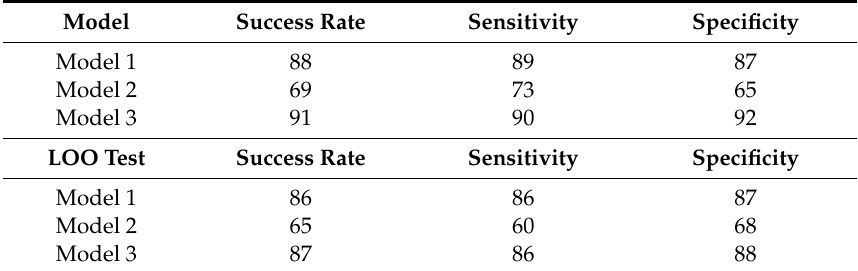
Table 5. Model comparison based on the ability to classify